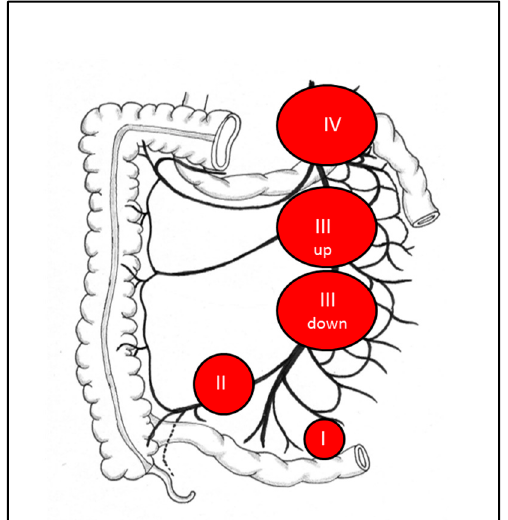
Figure 2. Classification based on the relationship between mesenteric lymph node metastases (MLNM) and the superior mesenteric vessels. Lymph node stage 0: no visible mesenteric MLNM suspicious of malignancy; Lymph node stage I: proximity to the small intestine, without invasion of the superior mesenteric artery lymph node (LN); Lymph node stage II: involvement of the distal branches of the superior mesenteric artery (SMA), next to their origin; Lymph node stage III: involvement of the trunk of the SMA, without involving the first jejunal arteries; III ‘up’: <3–4 free jejunal branches; III ‘down’: >3–4 free jejunal branches; Lymph node stage IV: involvement of the trunk of the SMA with involvement of the first jejunal arteries.